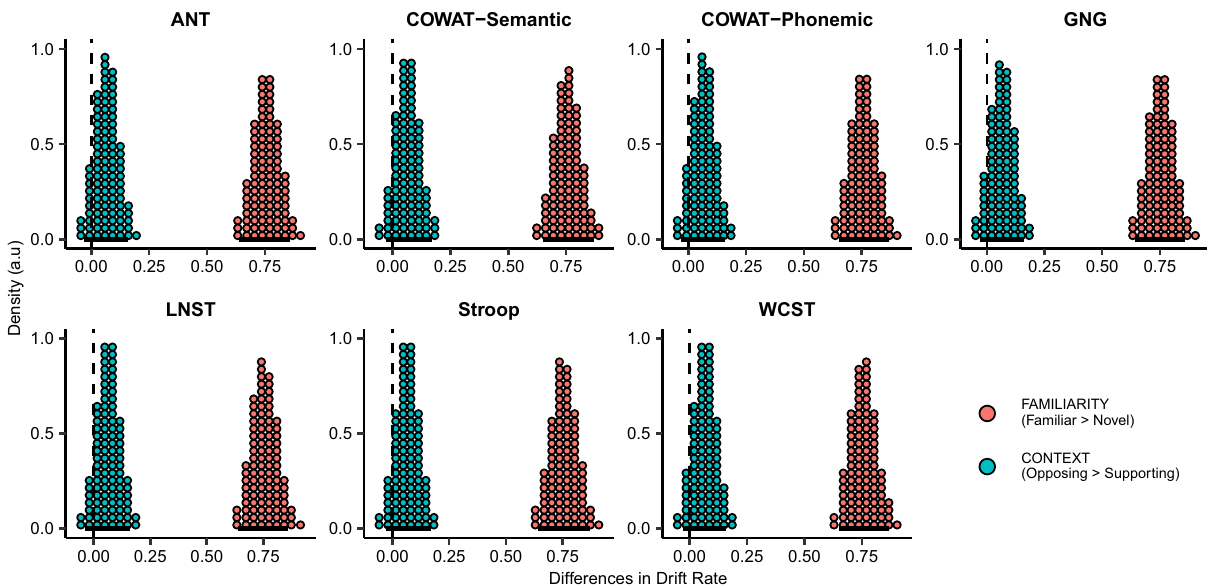
Figure 4. Population-level differences of drift rates with regard to the two factors (FAMILIARITY and CONTEXT). Population-level differences of posterior estimates for drift rates in seven Full models are described as quantile dotplots. One hundred dots for each posterior distribution represent quantiles from 0.5 to 99.5%. Therefore, the dots correspond to the posterior probability of whether differences in drift rates between the levels of each factor are positive or negative. In the case of the FAMILIARITY factor, since the difference between FMs and NMs was positive, drift rates were higher when participants were presented with FMs than with NMs (Familiar > Novel), with 100% credibility for all neuropsychological tests. With respect to CONTEXT, even if posterior estimates of drift rates were higher in OCs than in SCs (Opposing > Supporting), 95% HDI included zero in all the tests, meaning that the effect of CONTEXT on the drift rates was statistically insignificant. On the basis of a Bayesian hypothesis testing perspective, a factor has an effect on the drift rate when 95% HDI does not include zero. As more density resides away from zero, the effect of that factor becomes stronger. The black bars under dotplots represent 95% HDIs. ANT attention network test, COWAT controlled